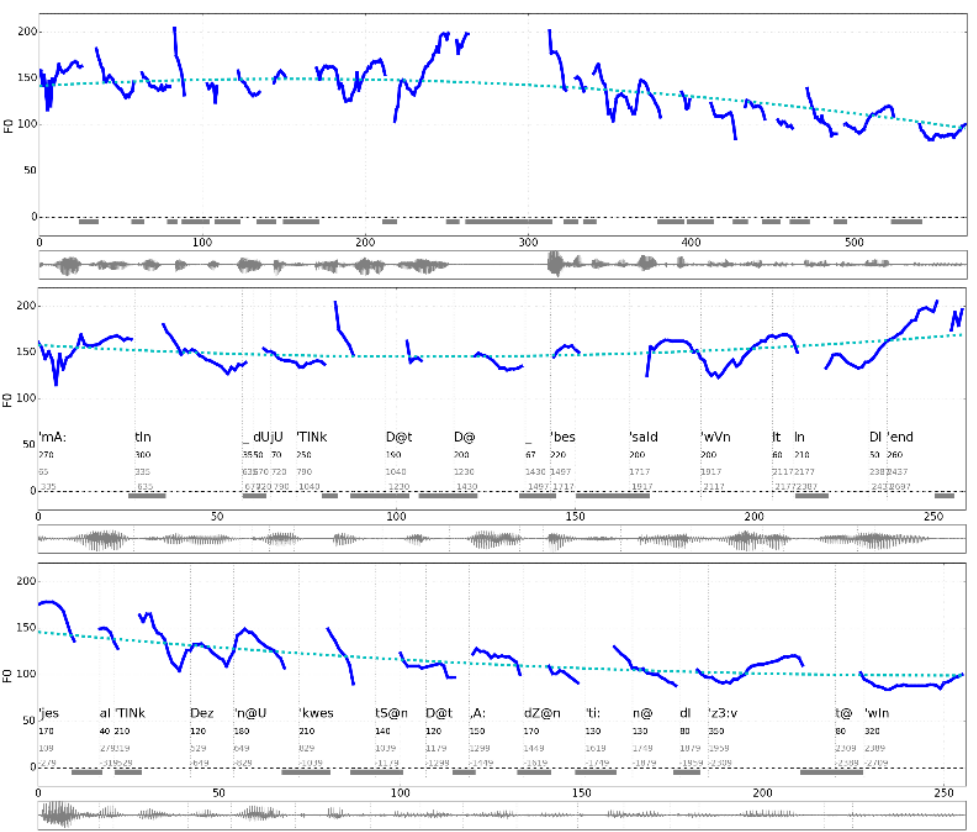
Figure 1: Question and answer (BBC interview, formal genre, male speakers, with quadratic regression